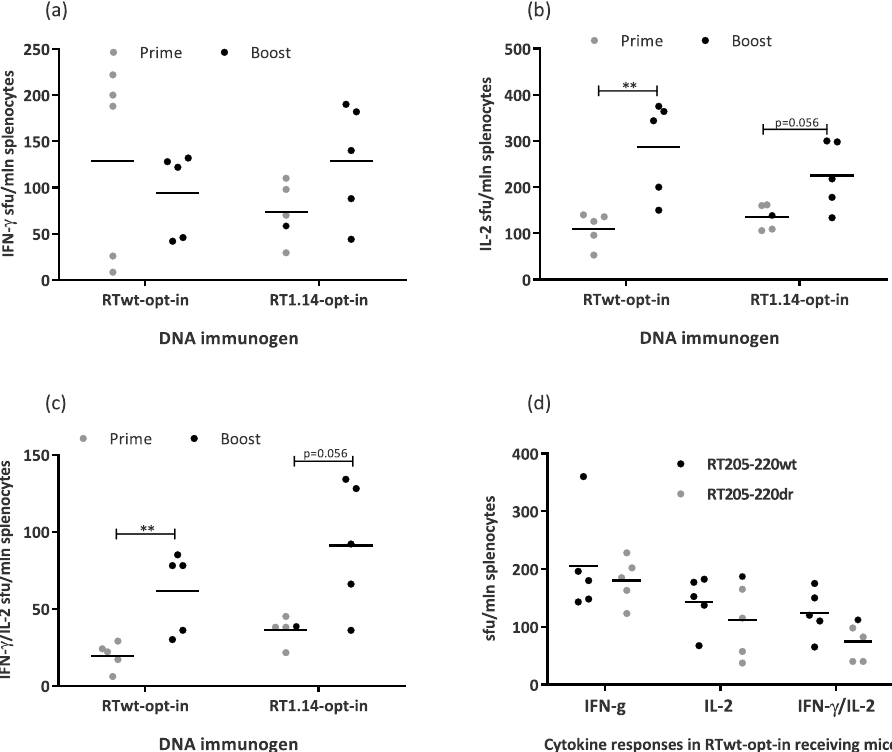
Figure 8. Cross-recognition of wt/dr proteins and peptides in RT gene-immunized mice. Mice were immunized as described in Figs 2 and 3. RT1.14 and RTwt proteins were used to stimulate splenocytes of mice immunized (either in the prime or prime-boost regimen) with RTwt-opt-in and RT1.14-opt-in encoding plasmids, respectively ( a – c ). RT205–220 wt/dr peptides (Table 1; d ) were used to stimulate splenocytes of mice immunized (in the prime regimen) with the RTwt-opt-in encoding plasmid ( d ). Results of the Flurospot test detecting IFN- γ , IL-2, and dual IFN- γ /IL-2 production are presented as the average number of cells, registered as signal-forming units (sfu) per million splenocytes secreting cytokines, and the error bars represent the SD. All assays were performed in duplicate. ** p < 0.01; p-values in the interval 0.05 to 0.1 indicate tendencies; p > 0.1 for comparison of responses to RT205–220 wt and RT205–220 dr ( d ). Statistical comparisons were performed using Mann-Whitney